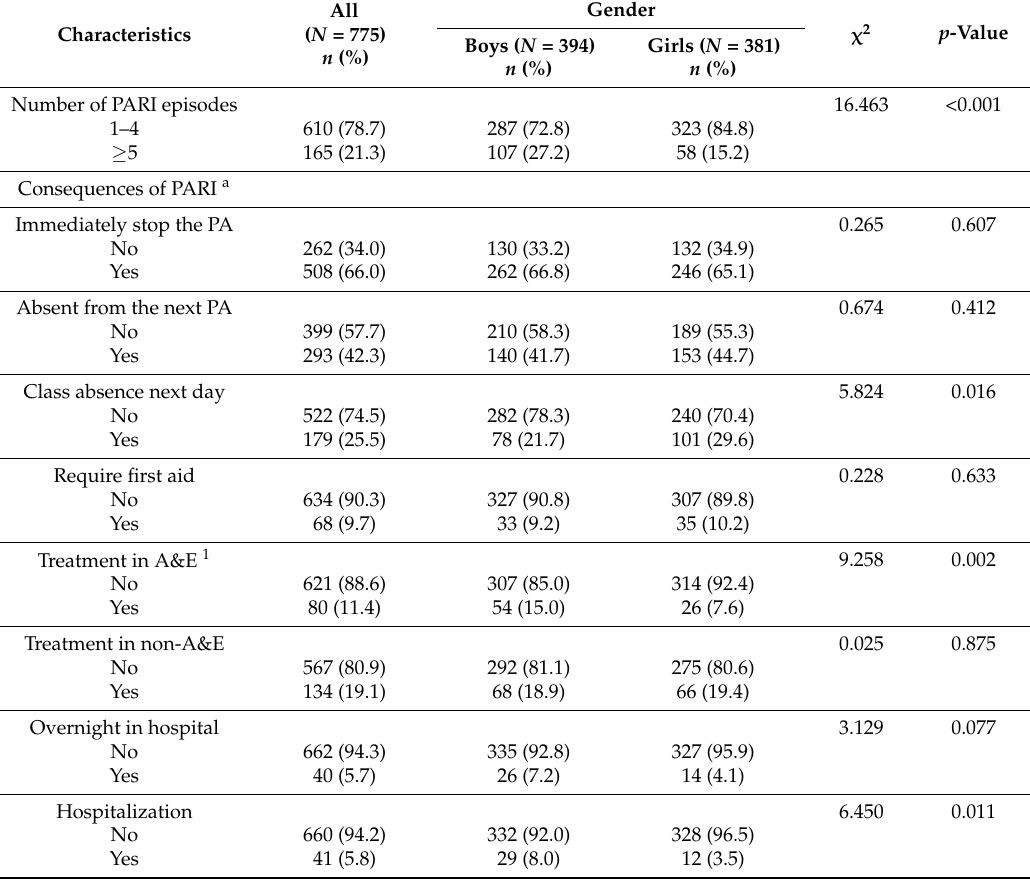
Table 4. Numbers and consequences of physical activity-related injury (PARI) between boys and girls.